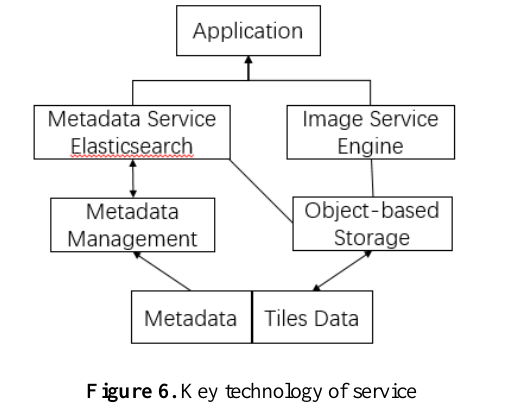
Figure 6. Key technology of